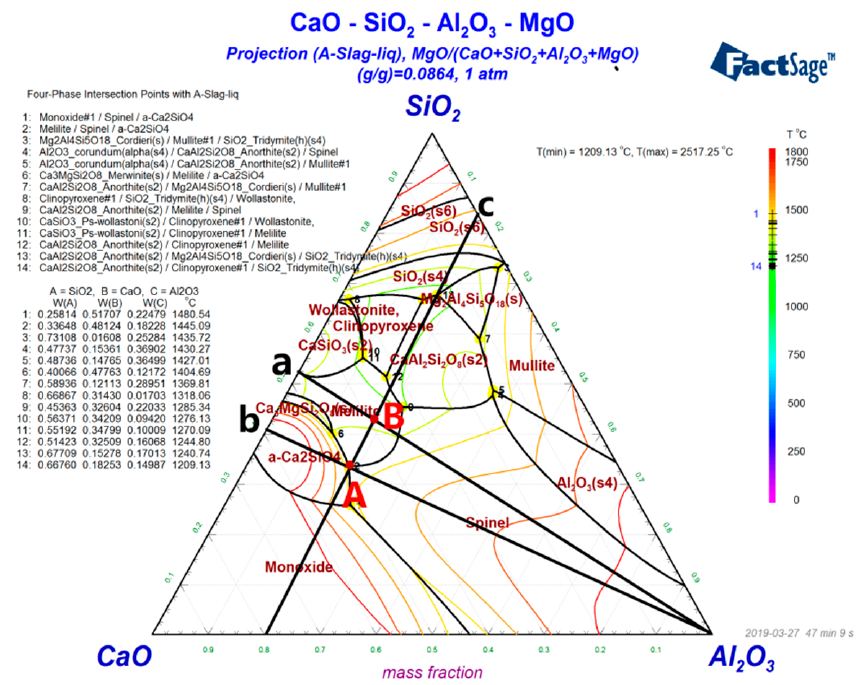
Figure 3. Phase diagram of the BFS with different basicities. Table 3. The viscosity of BFS with different basicities/(Pa·s).